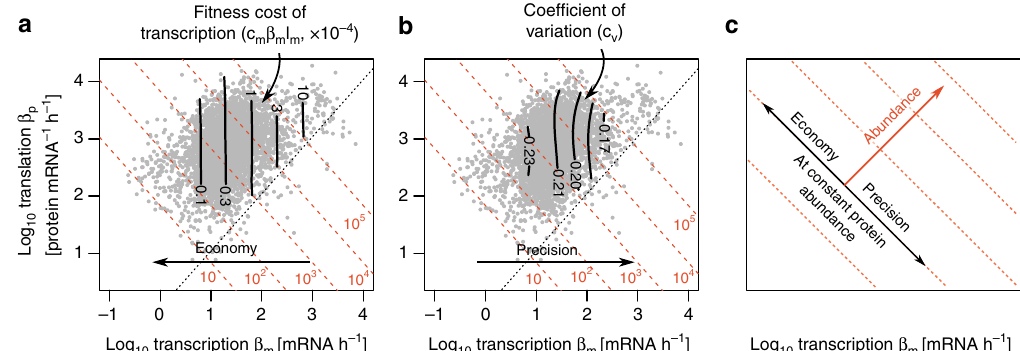
Fig. 3 Increasing transcription at constant protein abundance increases transcription cost and decreases stochastic fl uctuations in protein abundance. S. cerevisiae rates from Weinberg et al. 29 . Diagonal dotted lines are lines of constant protein abundance from 10 to 10 5 proteins per cell. a The loss of fi tness c m β m l m due to transcription (black lines) is linear in the transcription rates β m and the mRNA length l m . The linear factor c m (introduced in the next section) rescales transcription fl uxes [nt h − 1 ] into fi tness loss [h − 1 ]. In S. cerevisiae , l m = 1300 nt, c m = 10 − 9 nt − 1 . b Coef fi cients of variation (CV, black lines) scale with transcription rates. We applied 2D Gaussian smoothing on CVs (Methods). S. cerevisiae data: CVs from Newman et al. 17 , ribosome pro fi ling and mRNAseq data from Weinberg et al. 29 . c Precision in gene expression increases with transcription whereas protein abundance depends both on transcription and translation. Thus, at a given protein abundance, increasing transcription increases the precision of gene expression at the expense of higher transcription costs. See also Supplementary Fig.